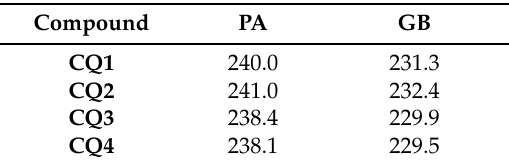
Table 2. Calculated Proton Affinities (PA) and Gas-Phase Basicity (GB), in kcal ¨ mol ´ 1 , for the protonation of oxygens 1 and 2 (same value for both oxygens) for all CQs. Results for all protonation sites are in the Supplementary Materials.